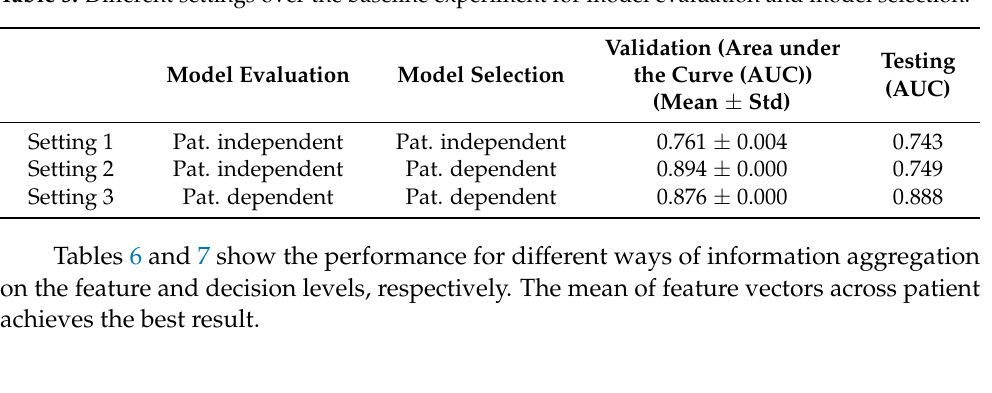
Table 5. Different settings over the baseline experiment for model evaluation and model